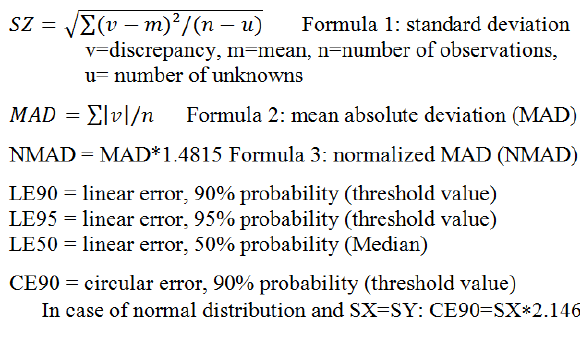
Figure 1: normal distribution with different accuracy figures probability of